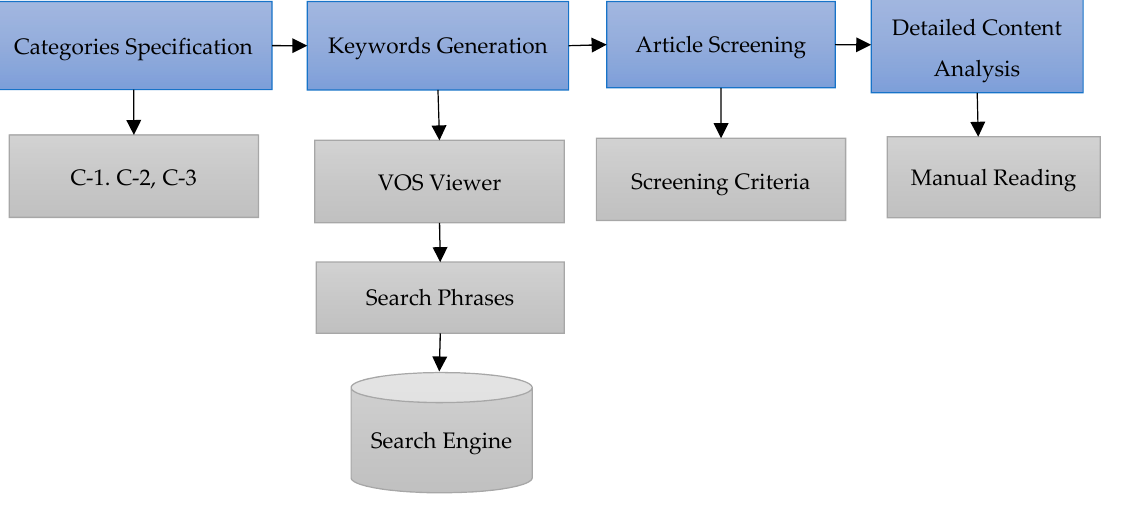
Figure 1. Methodology. Figure 1.